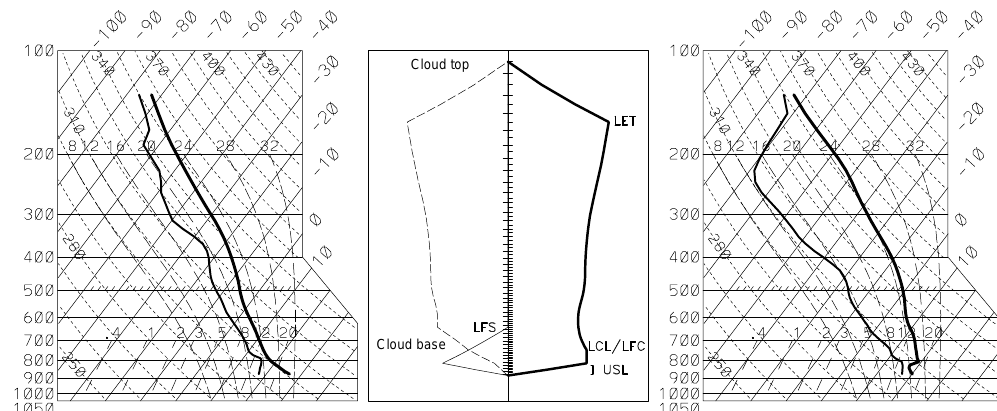
Figure 1. SkewT–logP thermodynamic diagrams for a deep tropical convective episode, before (left panel) and after (right panel) the action of convection as determined by the parametrization scheme: pressure on left axis in hPa, temperature on right and top axes in ◦ C. Middle panel: profiles of vertical mass fluxes as computed by the convection scheme: updraft ( F u , thick solid line), downdraft ( F d , thin solid line), environmental subsidence ( F e , dashed) needed to maintain the balance of mass at each level (see Fig. 2 for definitions). Vertical coordinate for the middle panel is pressure, with the same scale indicated for left and right panels. Horizontal coordinate is kgs − 1 m − 2 with arbitrary scale: the flux per unit area depends on the area attributed to the convective ensemble by the convection scheme. In this instance it is about 7% of the grid box. Also shown on the central axis are the locations of model levels. Significant levels for the convection computation are labelled on the graph. The air in the updraft source layer (USL) becomes saturated when raised to the lifted condensation level (LCL), and is unstable when further pushed to its level of free convection (LFC – at the same model level in this instance). Vertical acceleration of the rising air parcel ceases at the level of equilibrium temperature (LET) and vertical motion stops at cloud top. The convective downdraft begins at the level of free sink (LFS) and extends down to the ground.